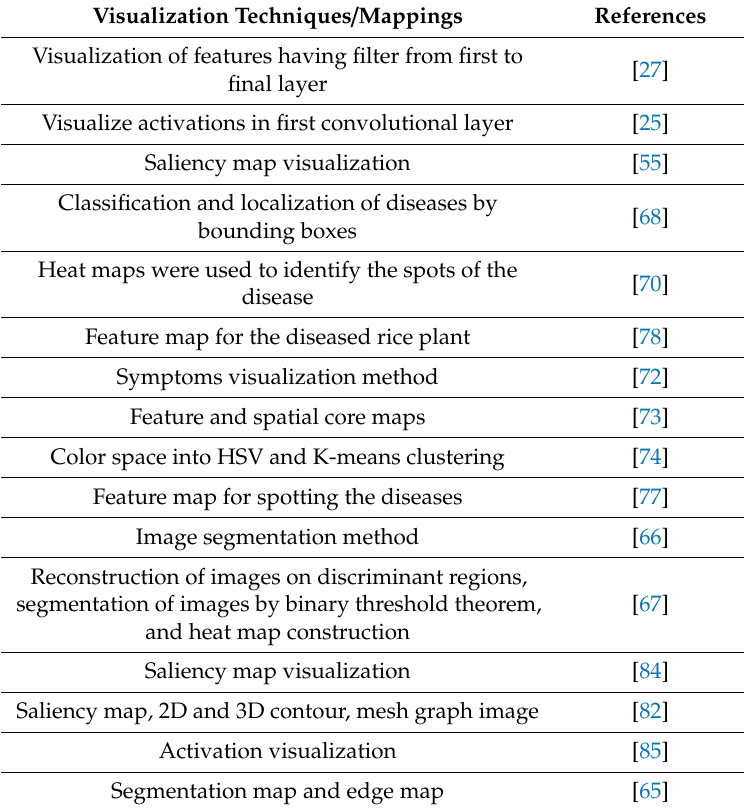
Table 2. Visualization mapping / techniques used in several